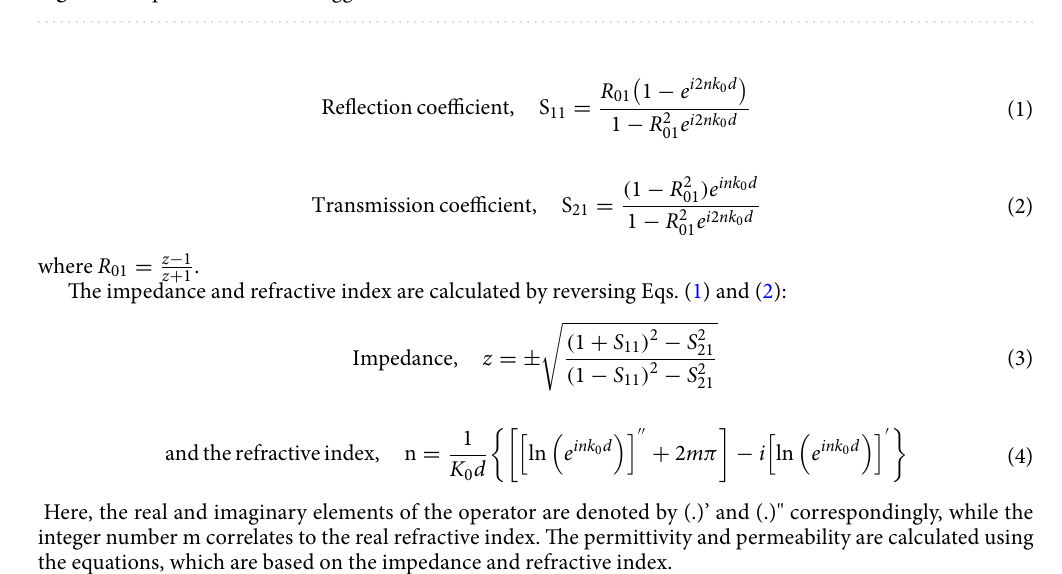
Figure 4. S-parameters of the suggested MM